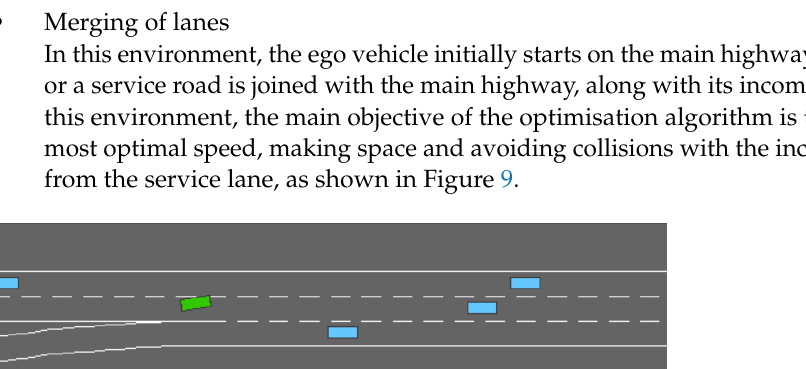
Figure 8. Lane changing in the highway environment (ego vehicle in green).